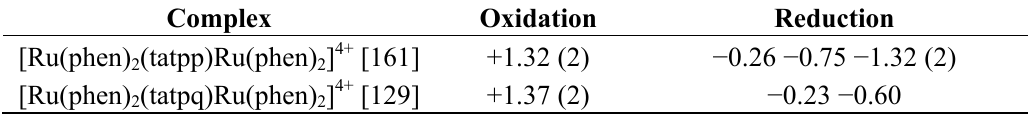
(tatpp)Ru(phen) ] 4+ and 2 2